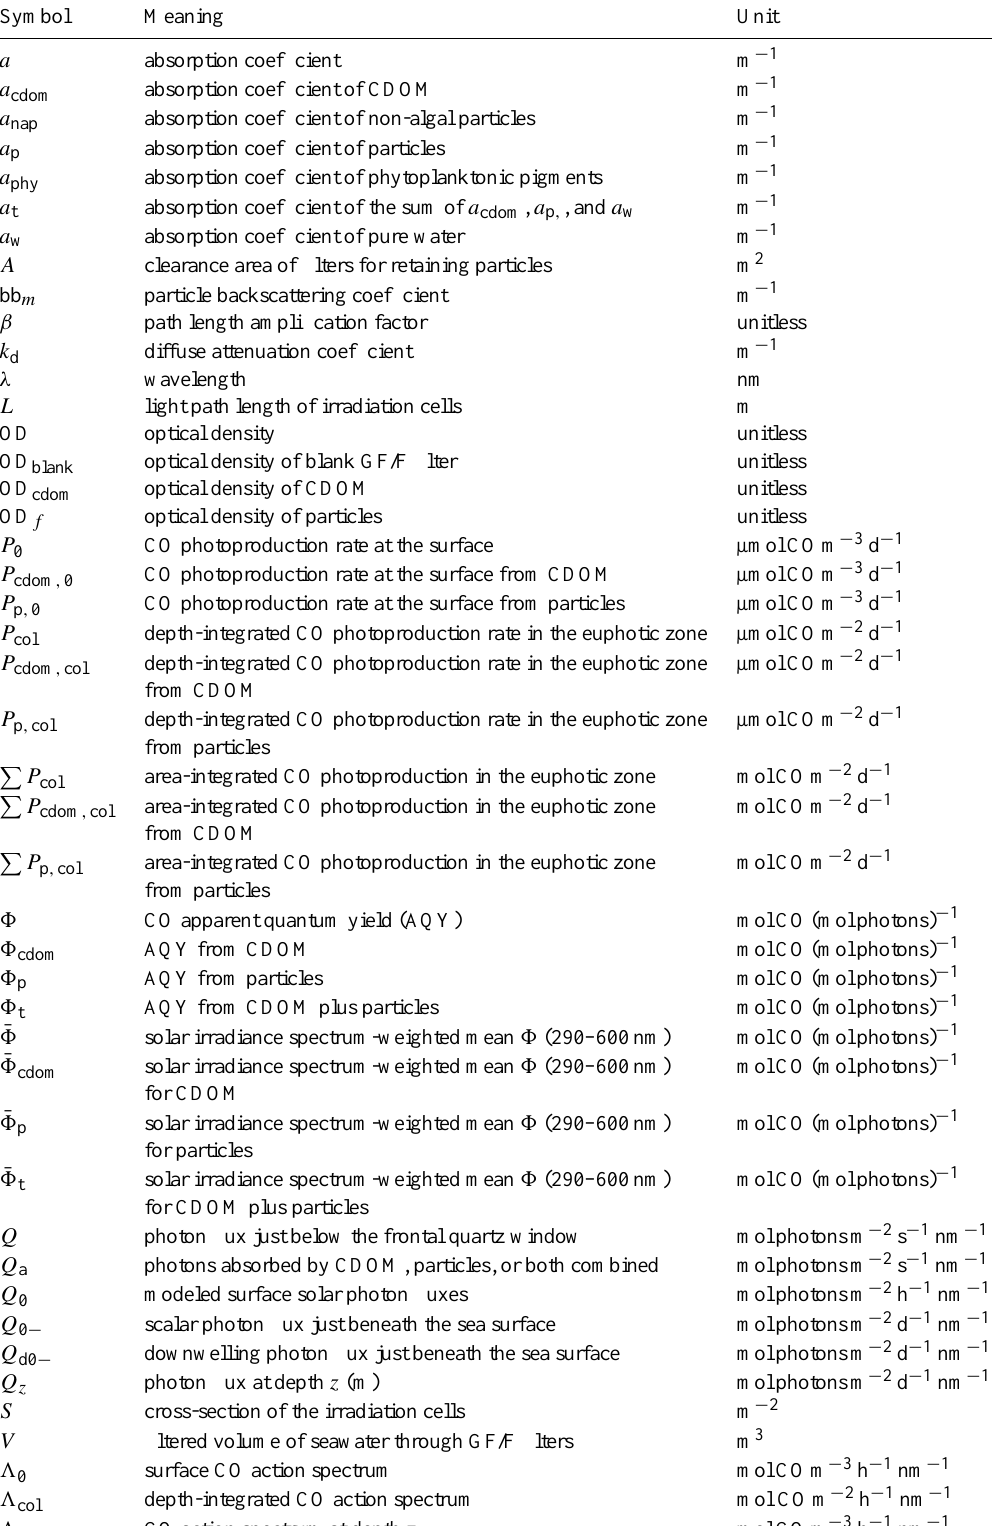
Table A1. List of